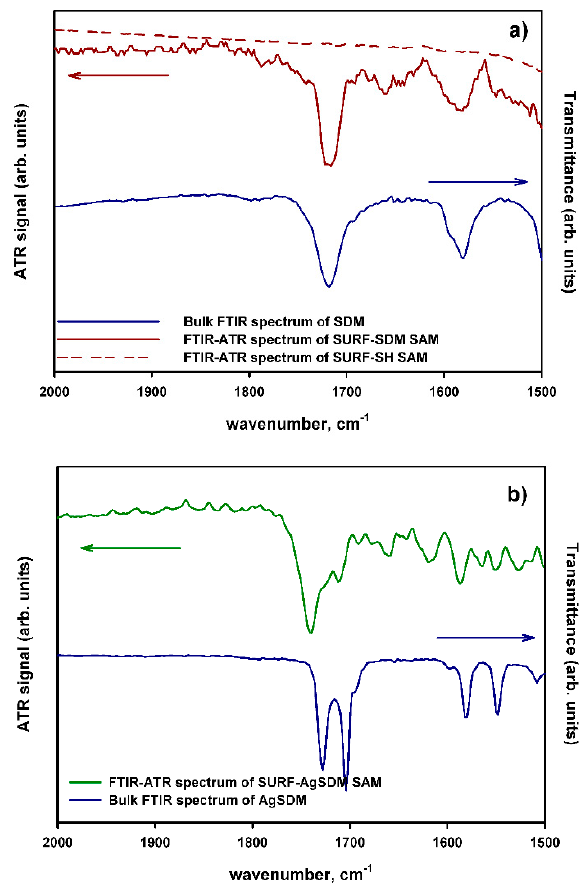
Figure 2. FTIR ATR spectra of ( a ) SURF-SDM (solid red line) SURF-SH (dashed red line) and bulk SDM (solid blue line); ( b ) SURF-Ag-SDM (green line) and bulk Ag-SDM (solid blue line).